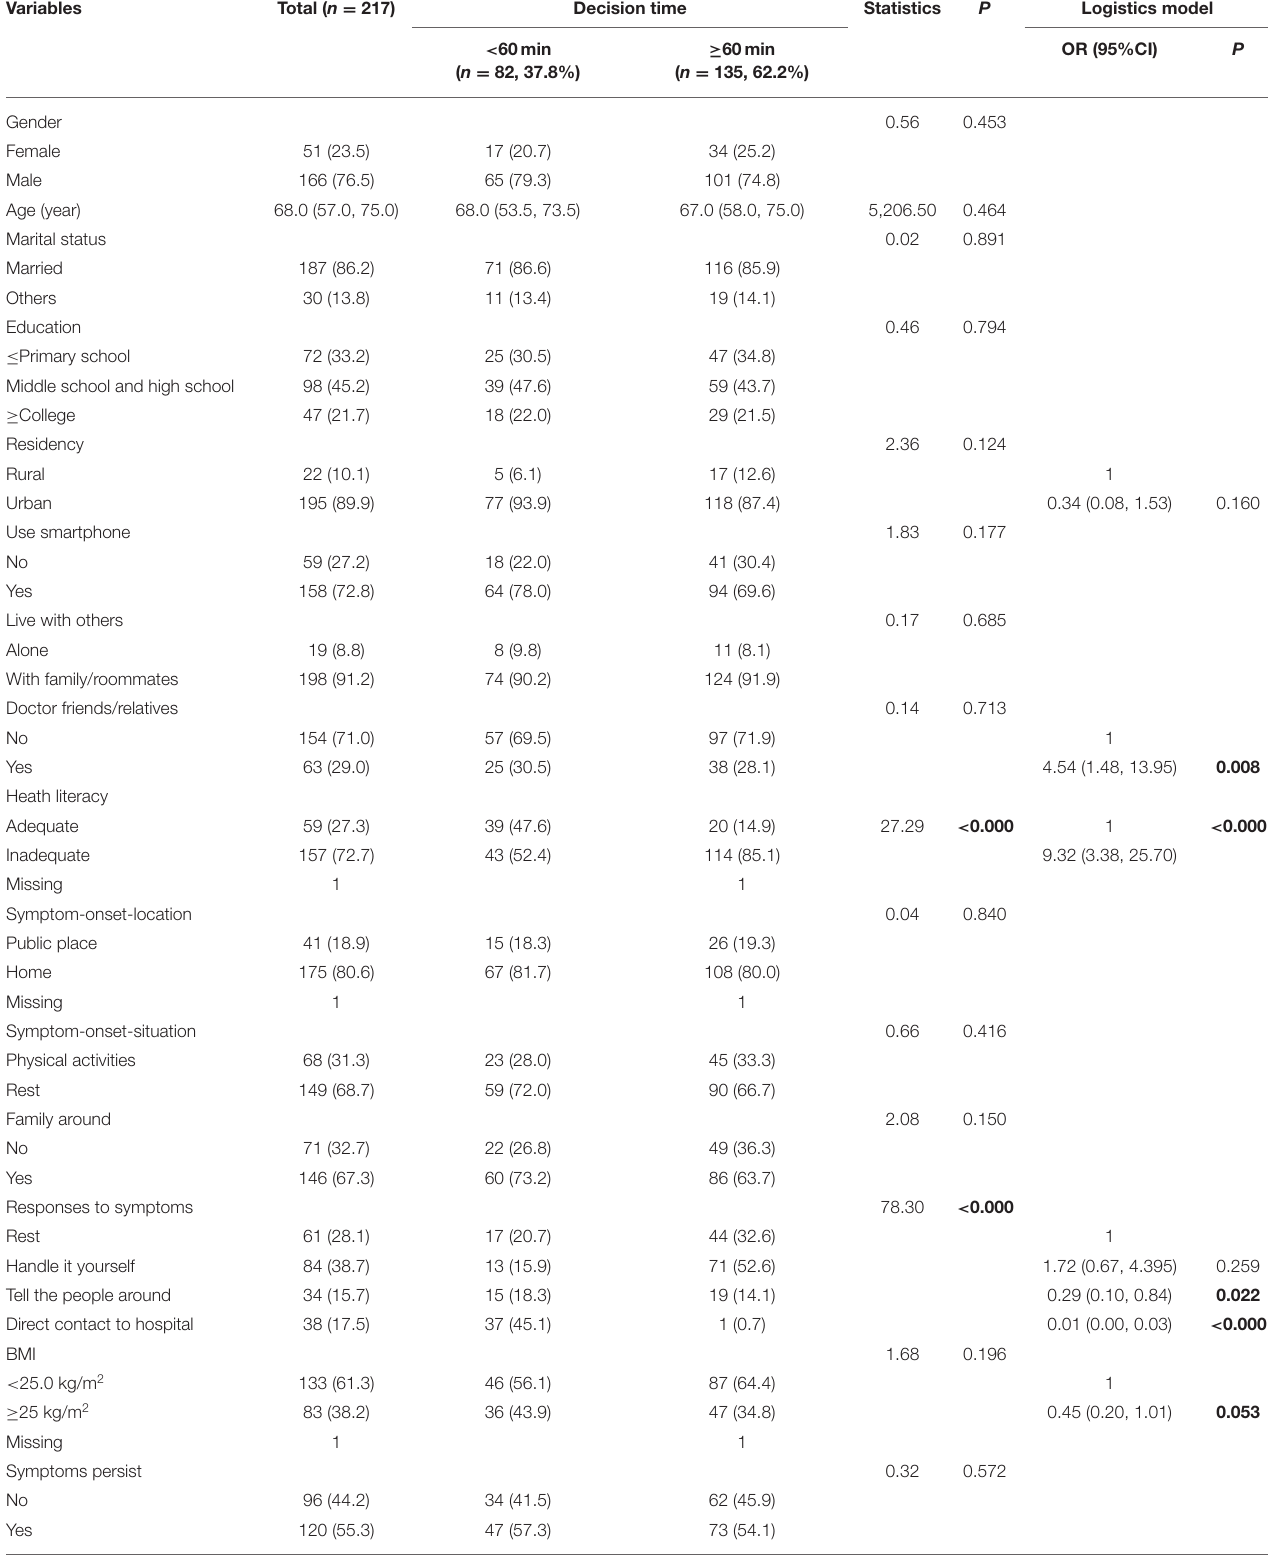
TABLE 1 | Characteristics of the study population and logistic regression analysis of the factors influencing decision delay. Variables Total ( n = 217) Decision time Statistics P Logistics